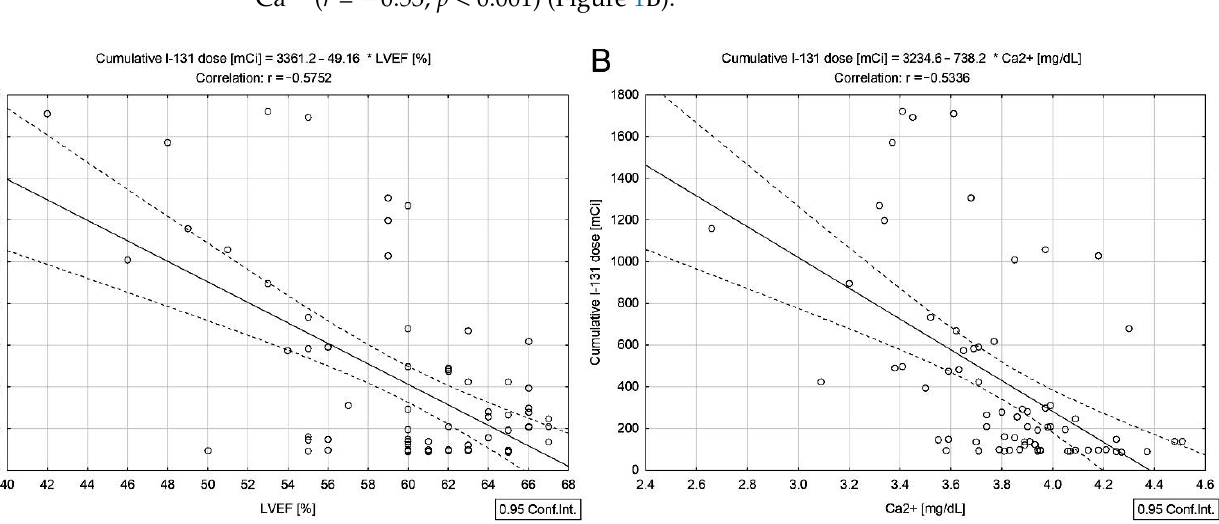
Figure 2. Correlations between the cumulative dose of 131 I and absolute lymphocyte count ( A ), NLR ( B ), and PLR ( C ) in differentiated thyroid cancer patients without type 2 diabetes mellitus. However, the LVEF was positively correlated with absolute lymphocyte count ( r = 0.44, p < 0.001) (Figure 3A) and serum Ca 2+ ( r = 0.29, p = 0.012) and negatively with NLR and PLR ( r = − 0.56 and r = − 0.42, p < 0.001) (Figure 3B,C). Figure 3. Correlations between LVEF and absolute lymphocyte count ( A ), NLR ( B ), and PLR ( C ) in differentiated thyroid cancer patients without type 2 diabetes mellitus.